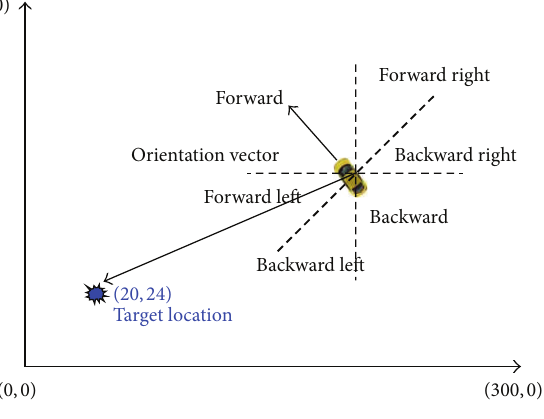
Figure 14: Relative orientation of target. Figure 15: Navigation to the